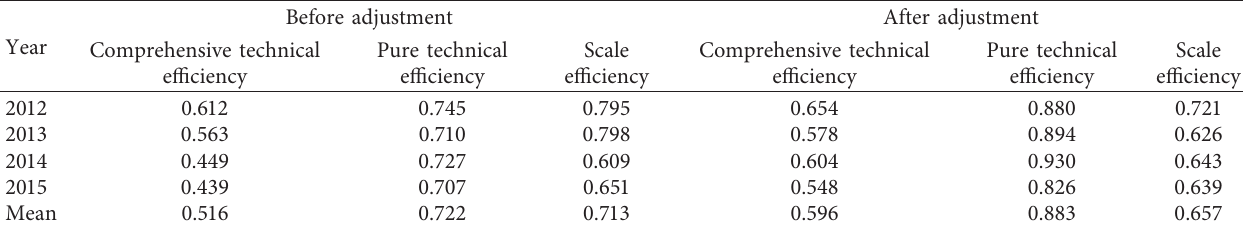
Table 5: Mean innovation efficiency before and after adjustment in each year. Before